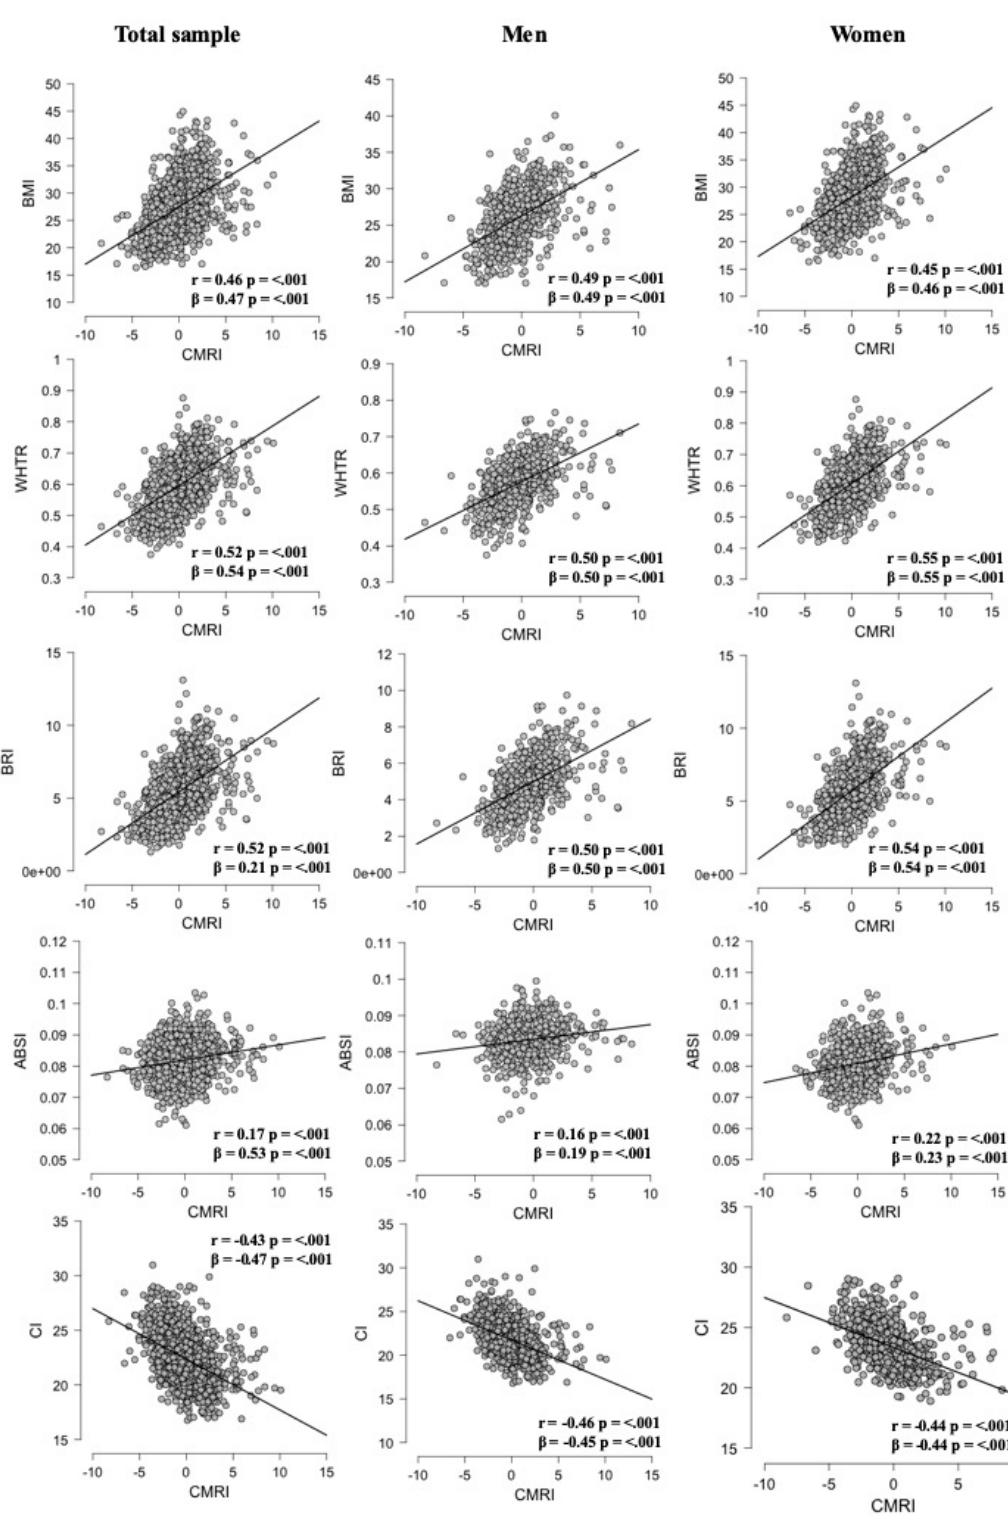
Figure 1. Association between surrogate anthropometric indices and CMRI, on the total sample and stratified by sex. BMI: body mass index; WtHR: waist to height ratio; BRI: body roundness index; ABSI: a body shape index; CI: conicity index; CMRI: cardiometabolic risk index.